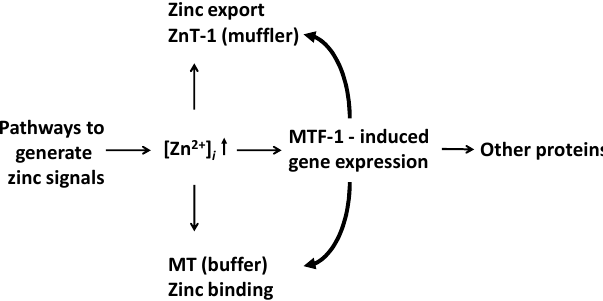
Figure 4. Genomic effects as a consequence of sensing zinc signals. MTF-1 induces the expression of the zinc exporter ZnT1 (muffler) and MT (buffer), which adjust the cellular zinc buffering capacity, and other proteins. In addition, constitutively expressed zinc transporters and MTs control the zinc signals.